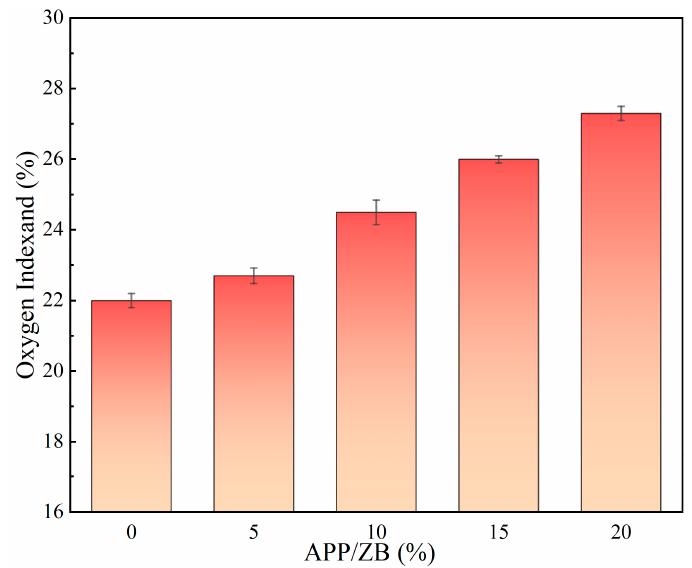
Figure 5. E ff ect of di ff erent APP/ZB content on the oxygen index of FWPC. Figure 5. Effect of different APP/ZB content on the oxygen index of FWPC.